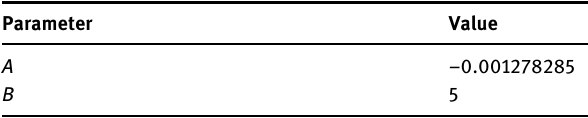
Table 2: Secant modulus of elasticity parameters